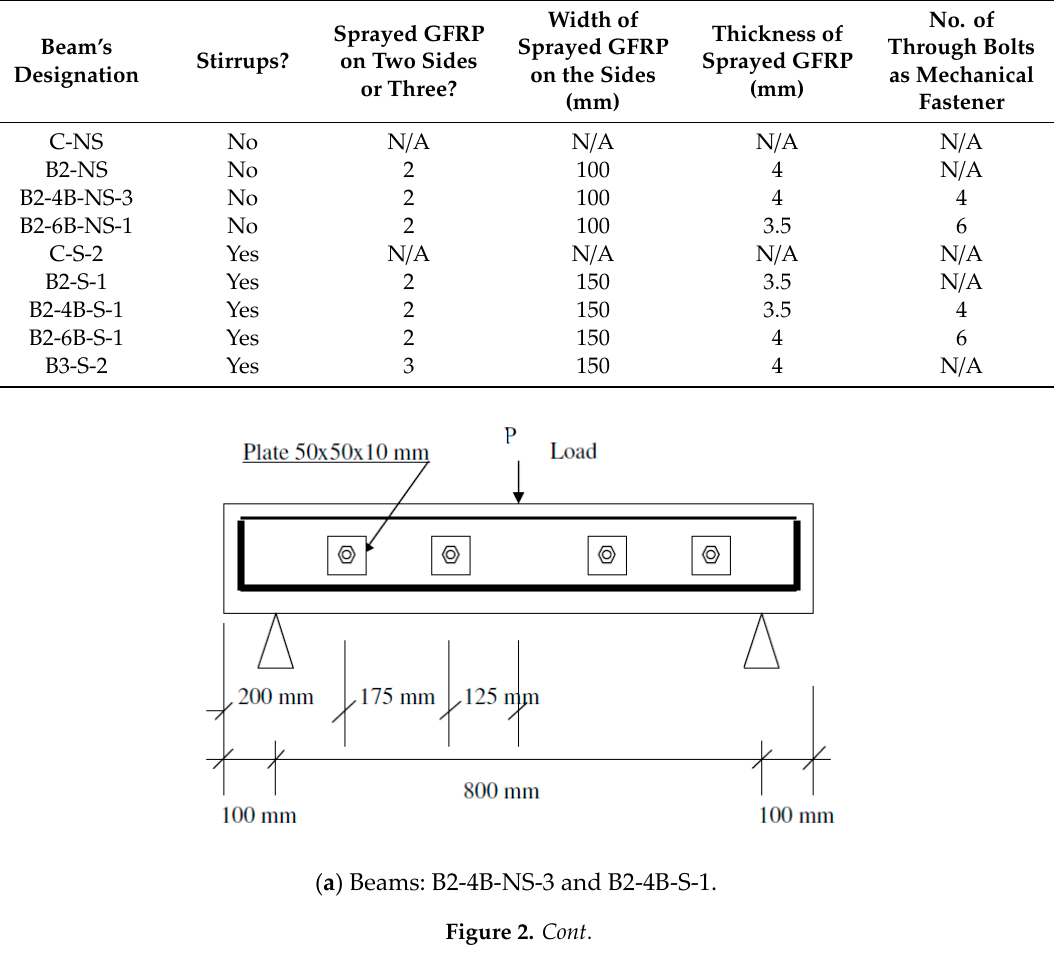
Table 4. Designations of RC beams tested under quasi-static loading as shown in Figures 1 and 2.